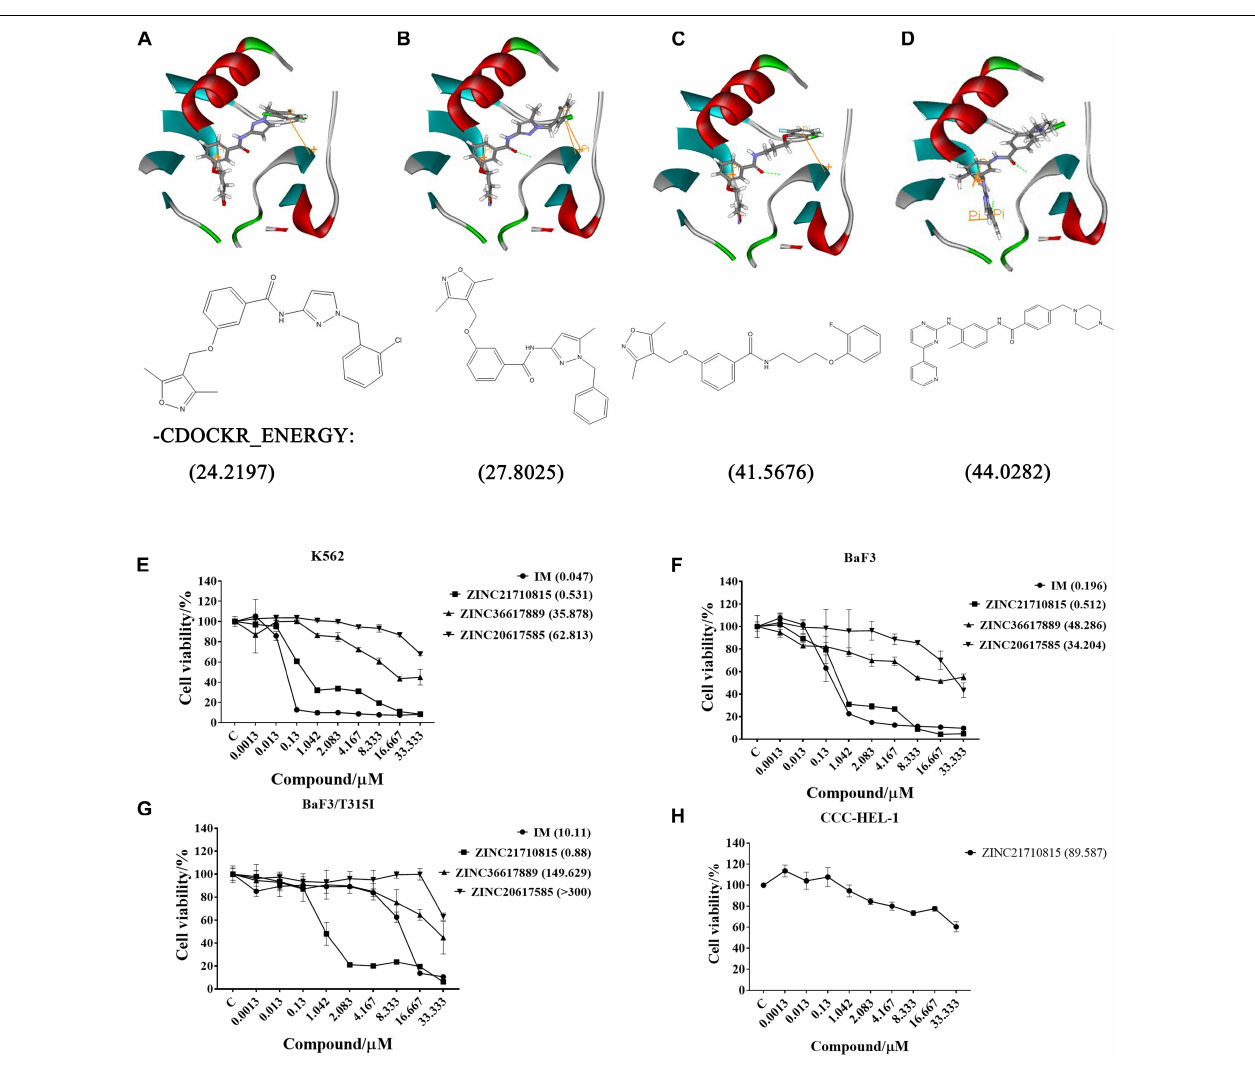
FIGURE 8 | The binding modes of three compounds and imatinib with the BCR-ABL protein (PDB: 1IEP): hydrogen bond (green), pi-pi (yellow). (A) ZINC20617585; (B) ZINC36617889; (C) ZINC21710815; and (D) Imatinib (IM). The effect of these compounds on the proliferation of (E) K562, (F) BaF3, (G) BaF3/T315I leukemia cells, and (H) CCC-HEL-1 cells. The cells were incubated with various concentrations of imatinib (IM), ZINC21710815, ZINC36617889, or ZINC20617585 for 72 h. The viability of the cells was assessed using the MTT assay. The results are represented as the mean ±